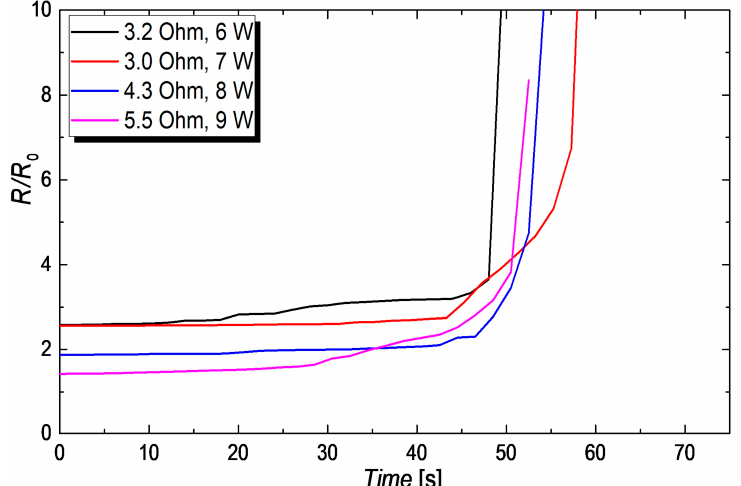
Figure A5. Normalized increase in resistance R / R 0 over time for CuNW films with a different initial resistance that were subjected to different electrical input powers. The x-axes for all films have been shifted to allow comparing the breakdown regions of each device.